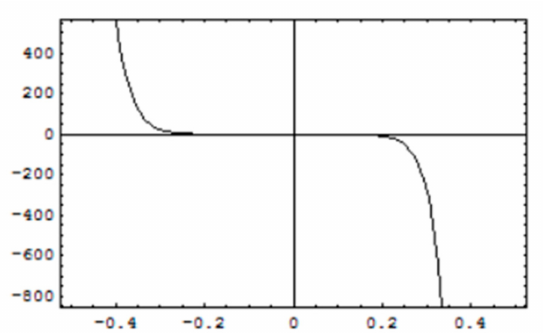
Figure 5. h -curves for solution of g (cid:48) ( 0 ) .